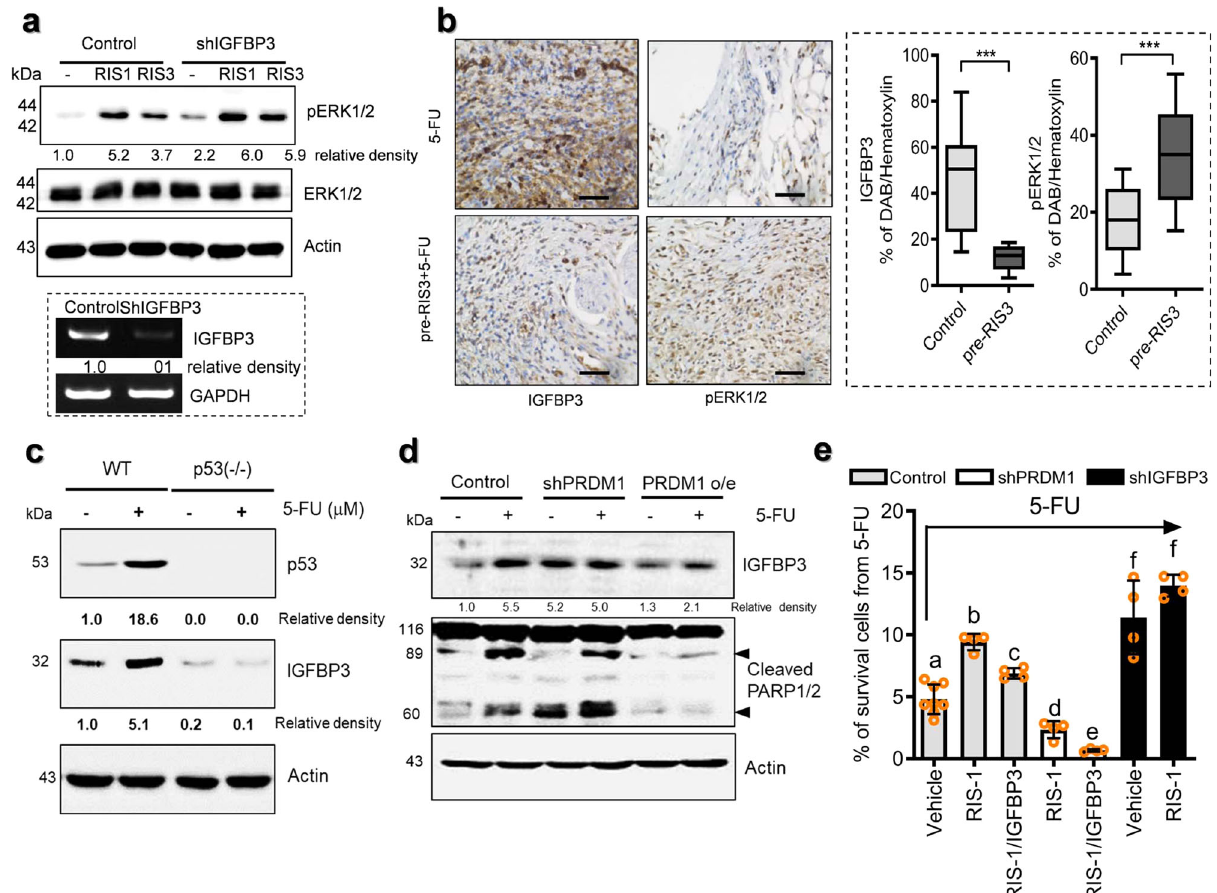
Fig. 6 Roles of IGFBP3 in chemoresistance. a The intestinal cancer cell lines (the negative control plasmid- or shIGFBP3-expressing HCT-8) were treated with DMSO, ID 90 of RIS-1 or ID 90 of RIS-3. Total cell lysates were subjected to western blot analysis. Figures in the lower box indicate IGFBP3 mRNA expression in cell lines. b Mouse tissues from allograft CRC were analyzed using immunohistochemistry for IGFBP3, and pERK1/2 (left panels) with hematoxylin counterstaining (magni fi cation ×400; scale bar(s), 100 μ m). Quanti fi cation of DAB staining from IHC analysis (right graphs). Results are shown as a plot with Tukey whiskers and asterisks represent a signi fi cant difference compared to the control group ( n = 11 or 14, *** P < 0.001). c p53 wildtype ( + / + ) and mutant ( − / − ) HCT-116 cells were treated with DMSO or 5-FU for 48 h. Total cell lysates were subjected to western blot analysis. d The intestinal cancer cells (the control vector-, shPRDM1- or PRDM1 overexpression plasmid-transfected HCT-8 cells) were treated with DMSO or 375 μ M 5-FU for 48 h. Total cell lysates were subjected to western blot analysis. e The intestinal cancer cell lines (the control plasmid-, shPRDM1- or shIGFBP3-expressing HCT-8) pre-exposed to the vehicle, ID 80 of RIS-1 or 50 ng/ml IGFBP3 for 24 h were treated with 375 μ M 5-FU for 48 h and mRNA levels were measured using RT real-time PCR. Results are shown as mean values ± SD and different letters (a – f) over each bar represent signi fi cant differences between groups ( n = 4 – 8, P <